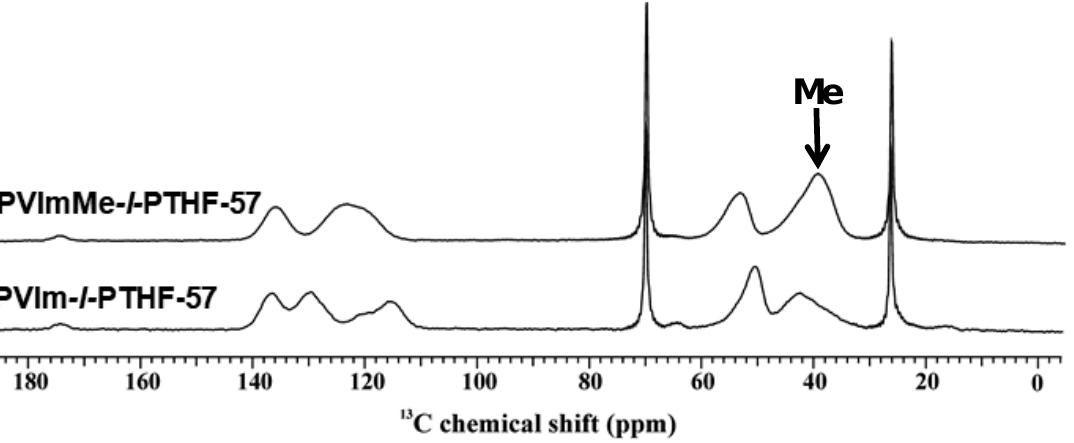
Figure 2. Solid-state 13 C NMR spectra of the PVIm -l -PTHF-57 and the methylated PVImMe -l -PTHF-57 poly(ionic liquid) conetworks.